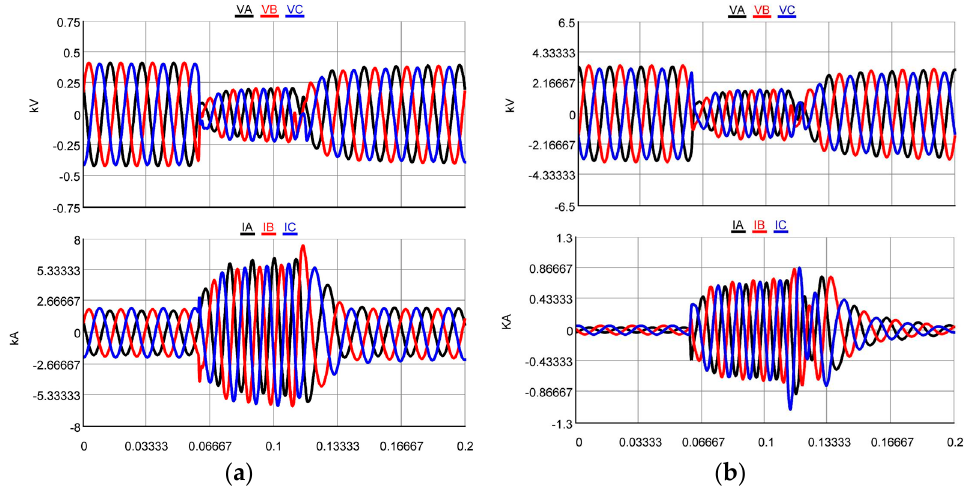
13 of 16 Figure 13. Three-phase fault applied at bus 6 in the transmission system of the testbed: ( a ) instanta- neous voltage and current at bus 634 with 750 W/m 2 solar irradiance; ( b ) instantaneous voltage and current at bus 680 with 750 W/m 2 solar irradiance. 3.4. Impact of Loading Levels on Solar PV Operation under Transmission-Level Faults Additionally, the impact of loading level on solar PV operation is investigated under the identified severe transmission-level fault type and location. In this case, the loading level is increased by four times its original loading level in the distribution system. Under the three-phase fault at bus 6 in the transmission system, the transient voltages and cur- rents at the solar PV buses are investigated. For comparison, Figure 14 shows the resulting voltage and current responses at solar PV bus 634 and bus 680 after the loading is in- creased. By comparing Figures 8 and 14, it can be seen that the maximum transient voltage